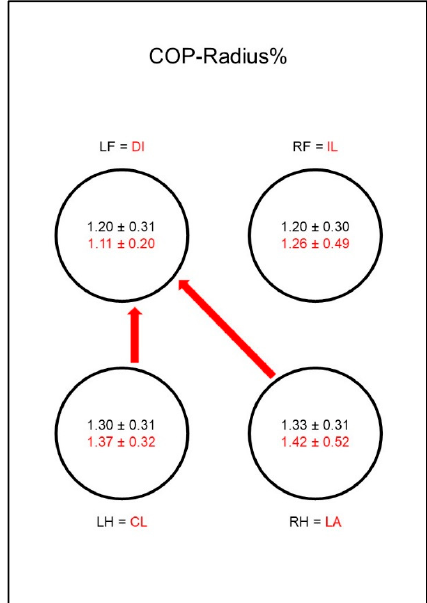
Figure 10. Mean distance of all center of pressure (COP) points to the center point of all COP points as a percentage of paw contact area (COP-Radius%) in study group 1 and control group. For detailed explanation and abbreviations refer to Figure